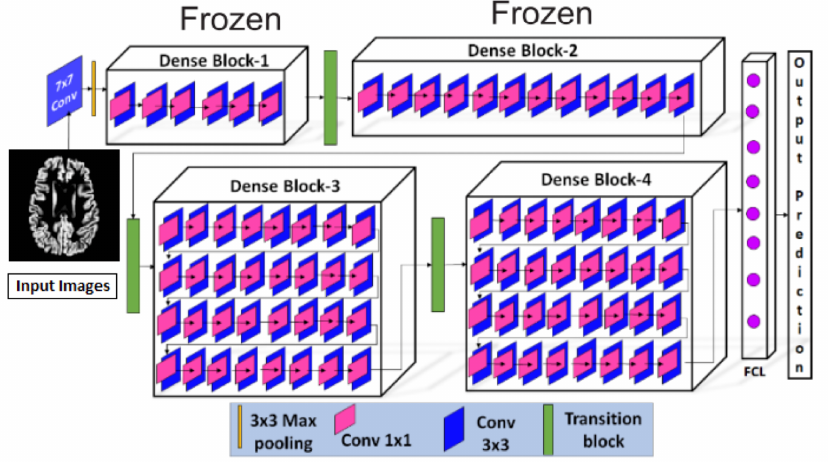
Figure 9. Proposed Model Architecture.